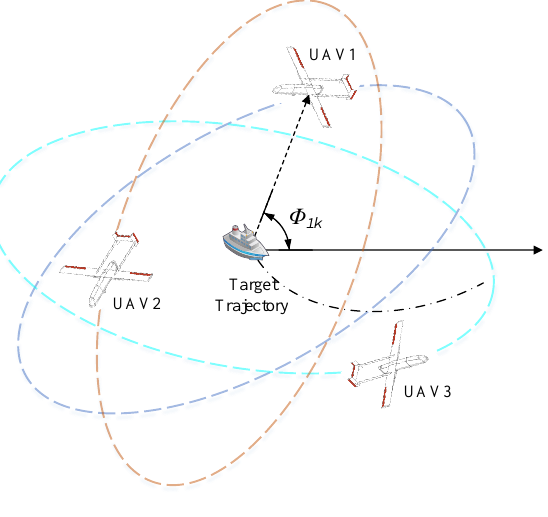
Figure 2. Multi-UAVs-based target tracking problem configuration at time t k . In this paper, three (03) UAVs are assumed to navigate independently following different circular and elliptical trajectories around the manoeuvring target with high-speed dynamic between 140 and 180